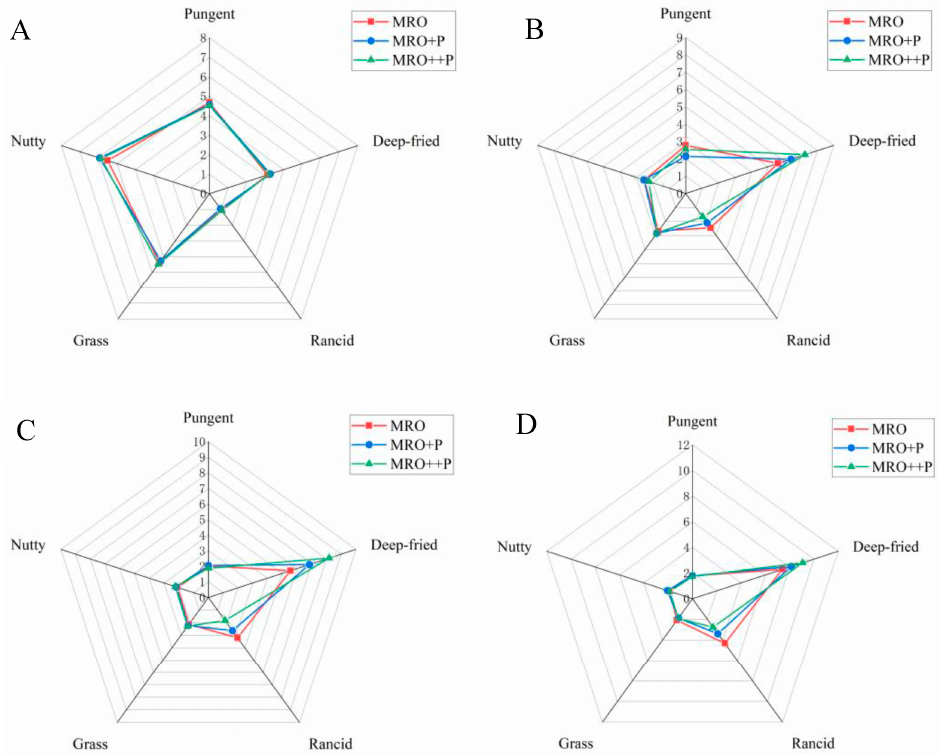
Figure 4. Fragrant rapeseed oil flavor sensory evaluation radar charts. Note: ( A – D ) respectively represent the sensory analysis results of the three oil samples after frying for 0, 8, 16 and 24 h.